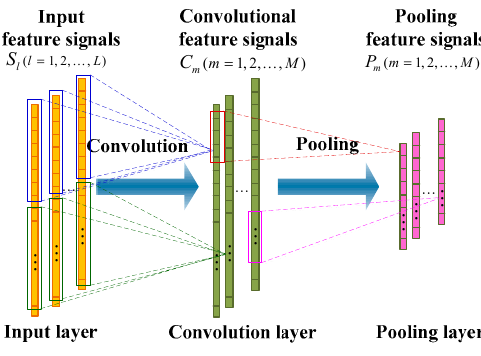
Figure 3. The deep-learning-based detection model proposed in this paper.